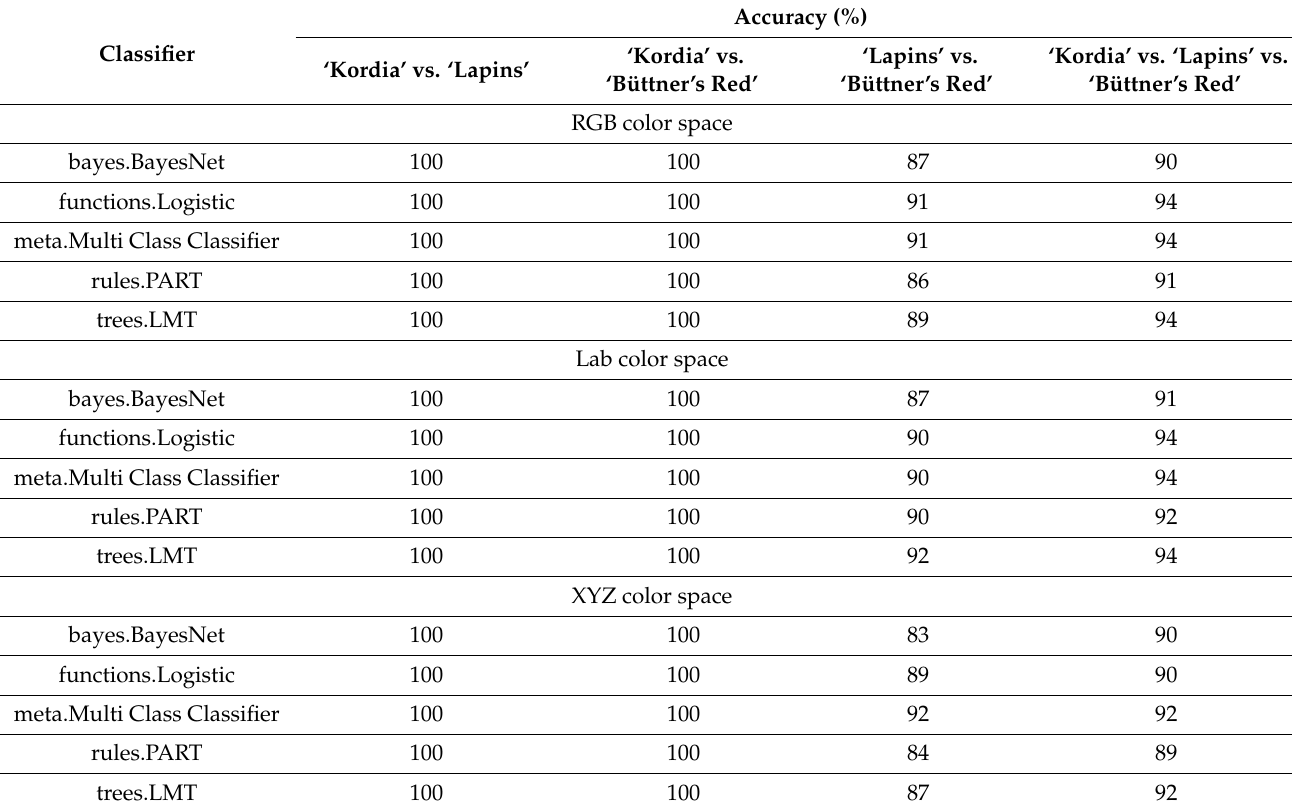
separately for color spaces (RGB, Lab, and XYZ) (Table 3), 100% accuracy was achieved for analyses of ‘Kordia’ vs. ‘Lapins’ and ‘Kordia’ vs. ‘Büttner’s Red’, for all color spaces and all classifiers. For RGB color space, the accuracies of 86% (PART classifier) to 91% (Logistic and Multi Class Classifier) were reached for discrimination of pits ‘Lapins’ and ‘Büttner’s Red’. The pits belong to three cultivars were correctly classified in 90% (Bayes Net classifier) to 94% (Logistic, Multi Class Classifier, and LMT) for RGB color space. In the case of Lab color space, the pits ‘Lapins’ and ‘Büttner’s Red’ were distinguished with the correctness of 87% (Bayes Net) to 92% (LMT). All three cultivars ‘Kordia’, ‘Lapins’, and ‘Büttner’s Red’ were characterized by 91% (Bayes Net) to 94% (Logistic, Multi Class Classifier and LMT) accuracies of pit discrimination. In the case of XYZ color space, discrimination accuracies for ‘Lapins’ and ‘Büttner’s Red’ ranged from 83% (Bayes Net) to 92% (Multi Class Classifier), and for ‘Kordia’, ‘Lapins’, and ‘Büttner’s Red’, the accuracies were in the range of 89% (PART) to 92% (Multi Class Classifier, LMT). These tendencies are similar to discriminant analysis performed for models built based on textures selected from all analyzed color channels ( R , G , B , L , a , b , X , Y , Z ) (Table 2). The correctness was the highest for discriminations of ‘Kordia’ vs. ‘Lapins’ and ‘Kordia’ vs. ‘Büttner’s Red’, and the lowest accuracy was obtained for discrimination of ‘Lapins’ vs. ‘Büttner’s Red’. Table 3. The accuracy of discrimination of the endocarp (pit) of different sweet cherry cultivars based on textures selected from individual color spaces. Accuracy (%) Classifier ‘Kordia’ vs. ‘Lapins’ vs. ‘Kordia’ vs. ‘Lapins’ vs. ‘Kordia’ vs. ‘Lapins’ ‘Büttner’s Red’ ‘Büttner’s Red’ ‘Büttner’s Red’ RGB color